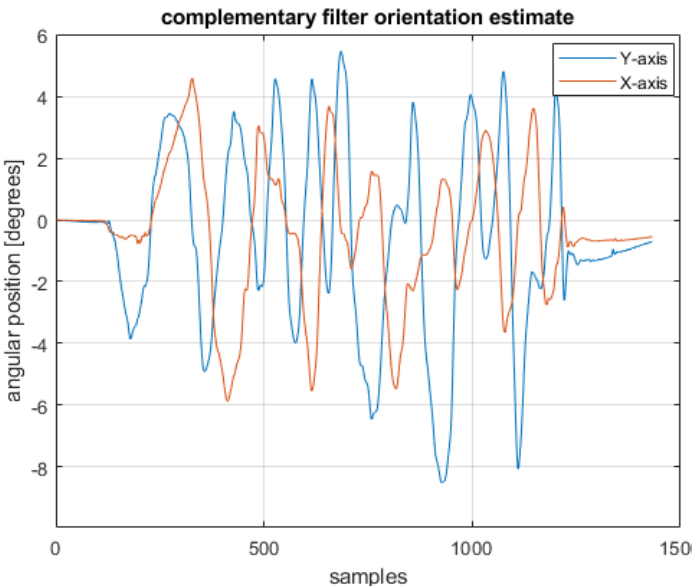
Figure 11. Position estimation using the complementary filter.